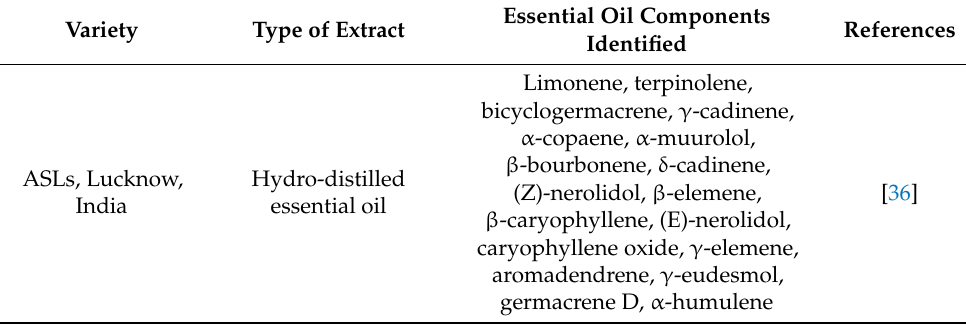
Table 2. Essential oil components reported in Annona squamosa L.